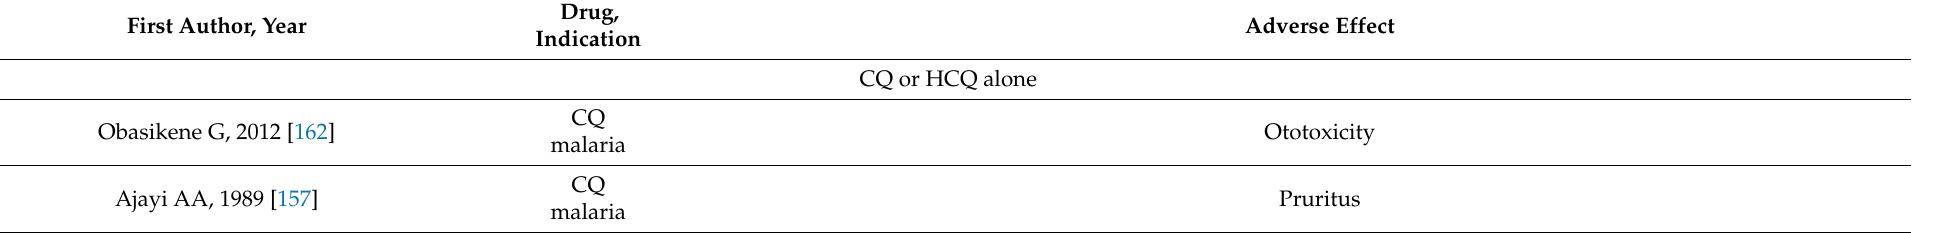
Table 5. Adverse effects reported on case-control studies and observational studies not included in data